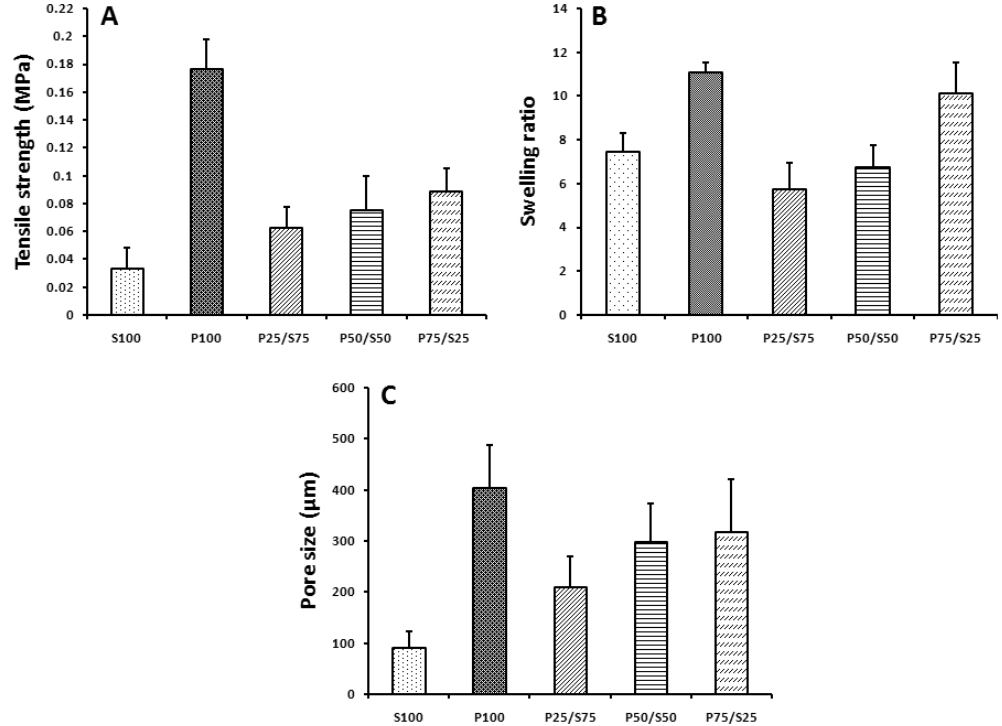
Figure 3. ( A ) Tensile strength, ( B ) swelling ratio, and ( C ) pore size of the hydrogels.